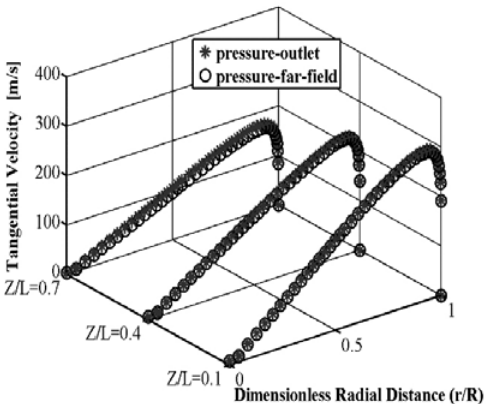
Fig. 9. Comparison of the axial velocities at different longitudinal sections regarding two different boundary conditions